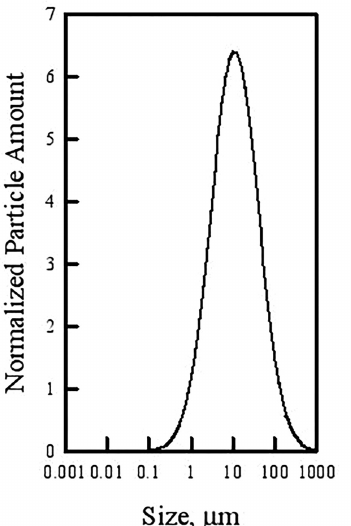
FIGURE 1 - Insulin-PCL particles size distribution. Particles were evaluated by DLS after dispersion in water. Mean particle diameter = 9.8 + 0.57 m m. Details in the Material and Methods section.